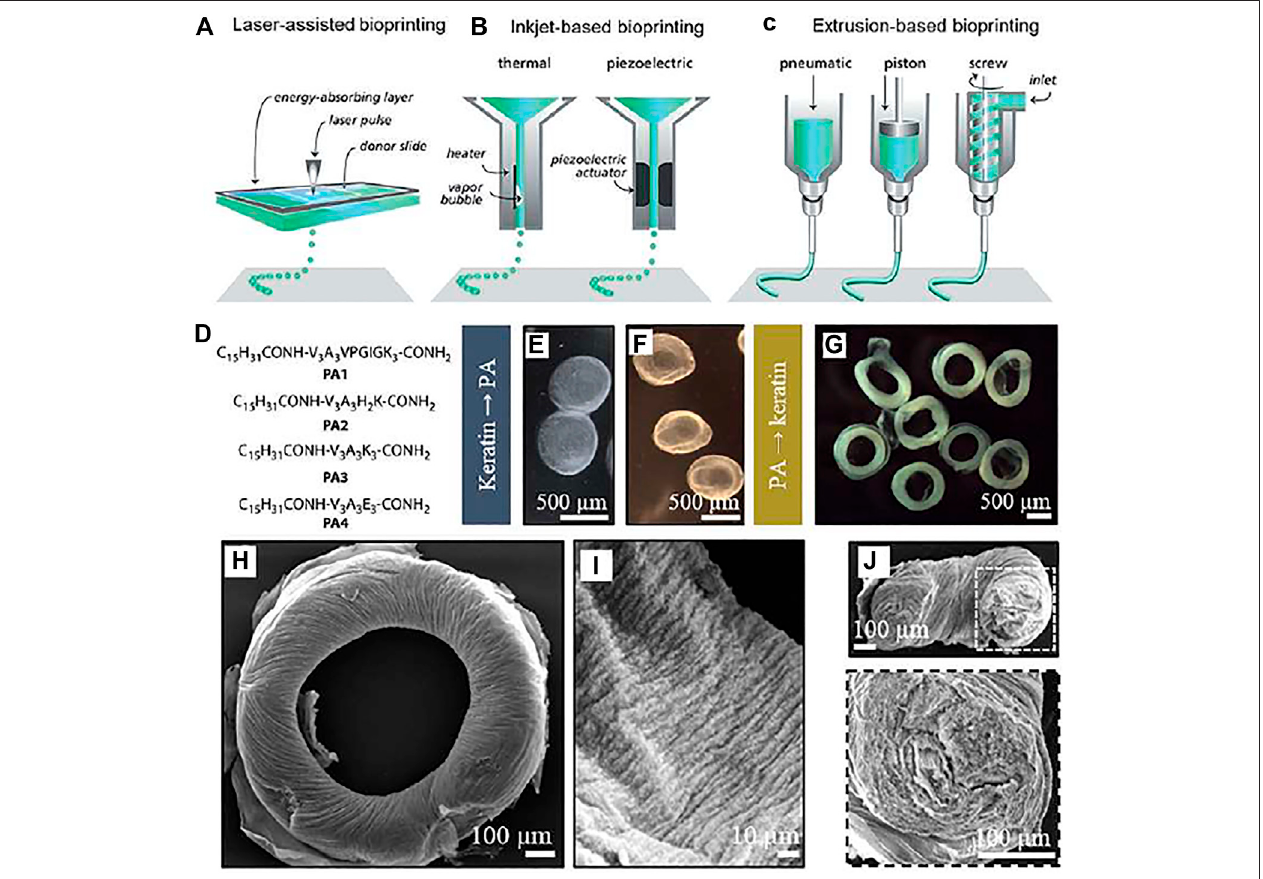
FIGURE 8 | Use of peptide based hydrogels in 3D bioprinting. (A – C) Three different approaches for biofabrication involving the use of hydrogels in the form of “ bioink ” . D) Sequences of peptide amphiphile based hydrogels used for 3D printing. Images of E) biconcave gels made with keratin (20 mg ml − 1 ) and (F) keratin (10 mg ml − 1 ) jetted into PA1 (10 mg ml − 1 ) and (G) of toroidal gels made with PA1 (10 mg ml − 1 ) jetted into keratin (10 mg ml − 1 ). (H) SEM image of one toroidal gel (500 μ m) and (I) zooming in on the surface architecture of a toroidal gel, and (J) a cross-section of a PA1/keratin hydrogel and an enlargement of the right hand cross-section. (A – C) Reproduced with permission (Malda et al., 2013). Copyright 2013 WILEY VCH. (D – J) Reproduced with permission (Hedegaard et al., 2018). Copyright 2018 WILEY VCH.